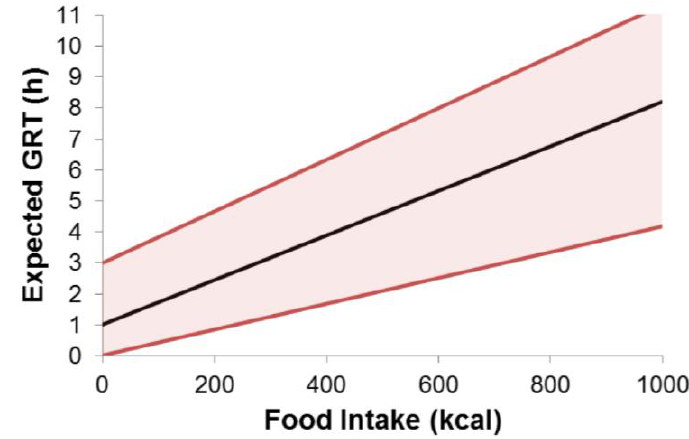
Figure 15. Expected maximum and minimum gastric residence times (GRTs) for larger, non-disintegrating objects according to the above stated rule of thumb (solid, red lines). The solid, black line represents the linear relationship demonstrated by Waterman [12].